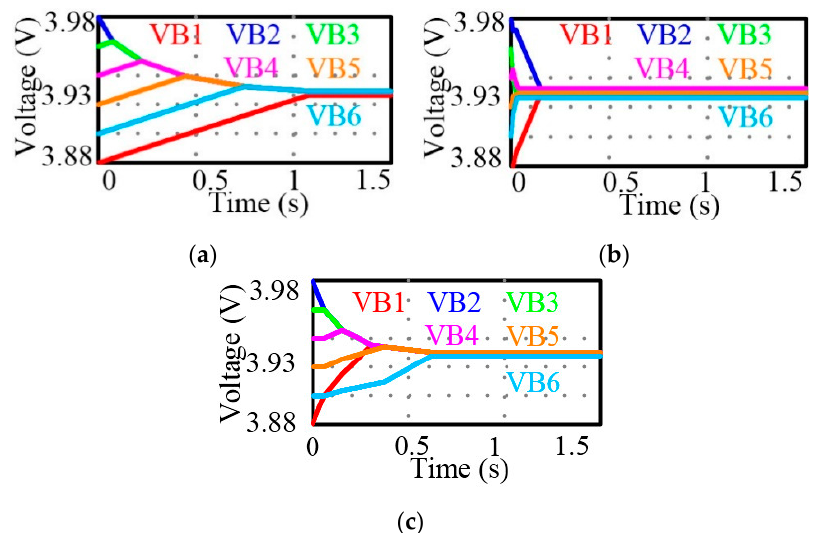
Figure 7. Six cell voltage trajectories in simulation. ( a ) The SSIE. ( b ) The PAE. ( c ) The NIBNDE.